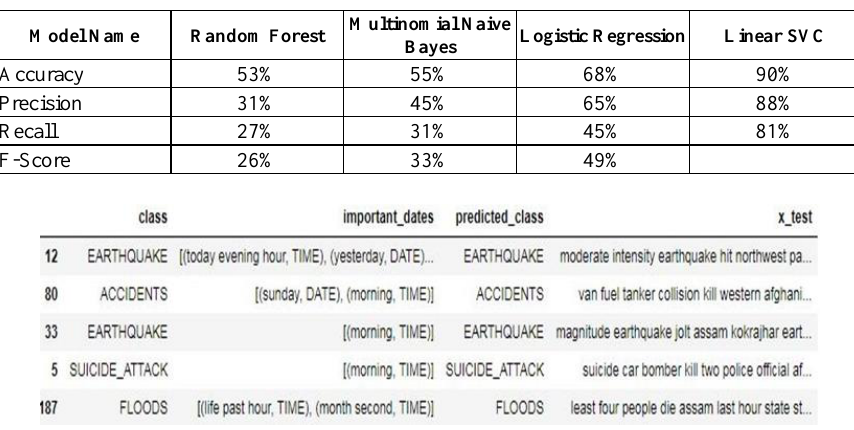
Table 5. Comparison of accuracy parameters with different classifiers